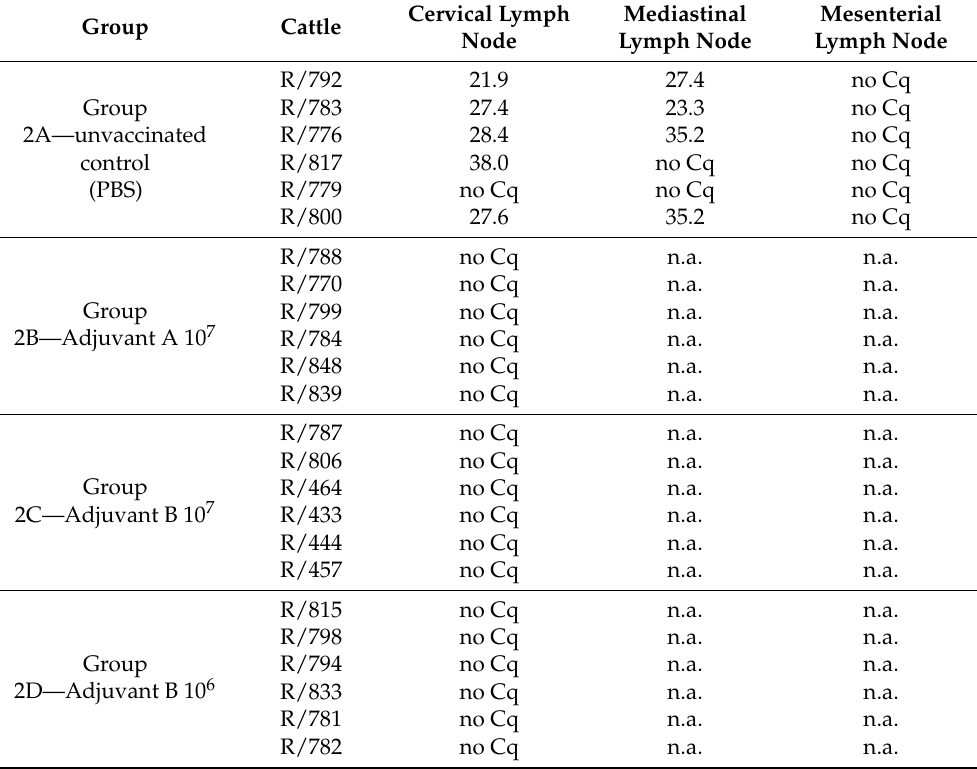
Table 3. Viral genome load in certain lymph nodes taken during necropsy. Taken